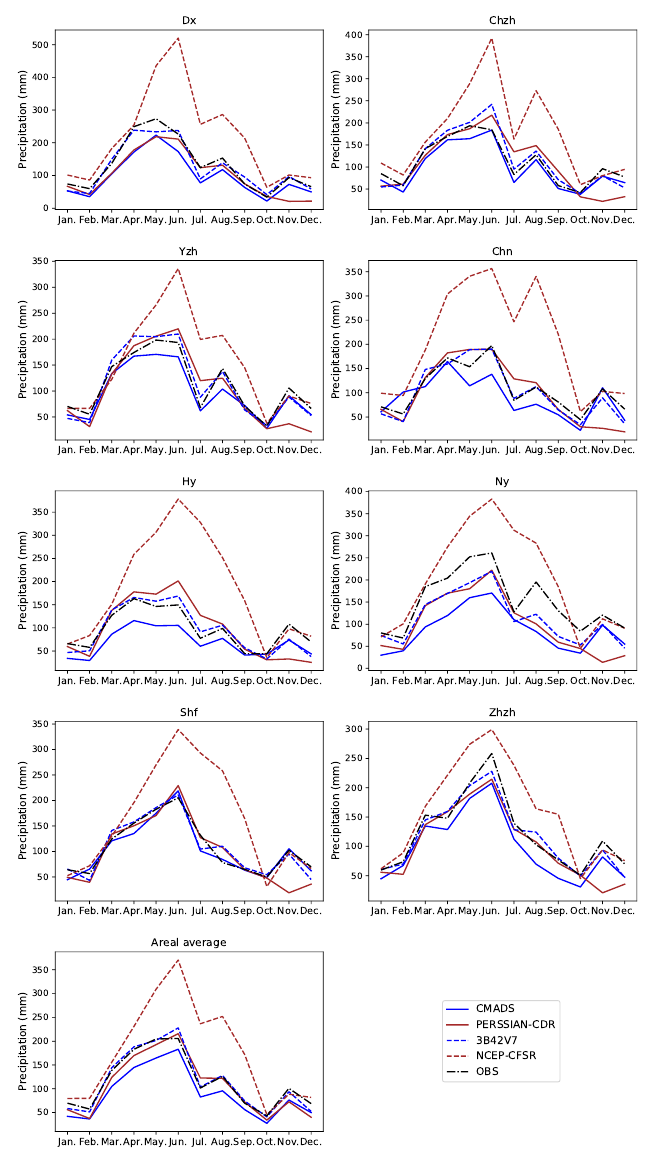
Figure 3. Multi year average monthly precipitation (OBS represents gauge